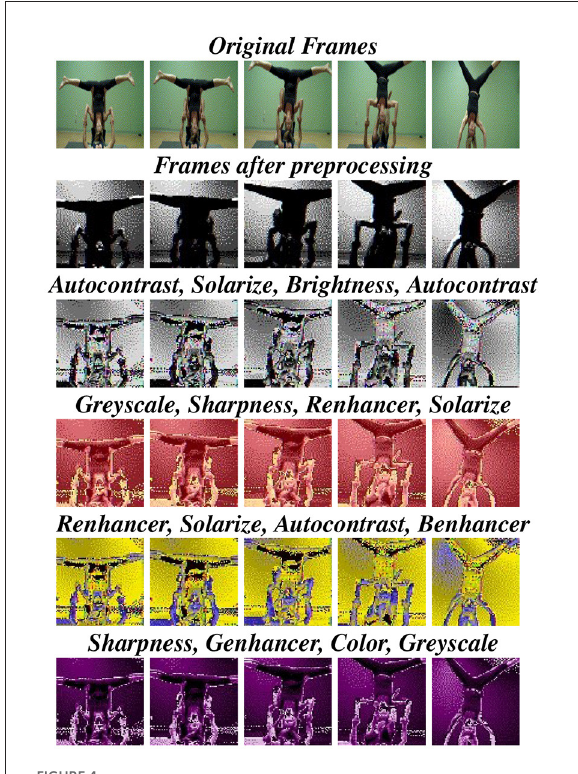
FIGURE4 This figure presents frames sampled equally from a video in class “Yoga”. The first set of frames belongs to the Kinetics GIFs dataset, and is followed by the frames after Batch Normalization is applied. The subsequent set of images depicts the frames after tuples of transformations, chosen by the random search approach, are applied to